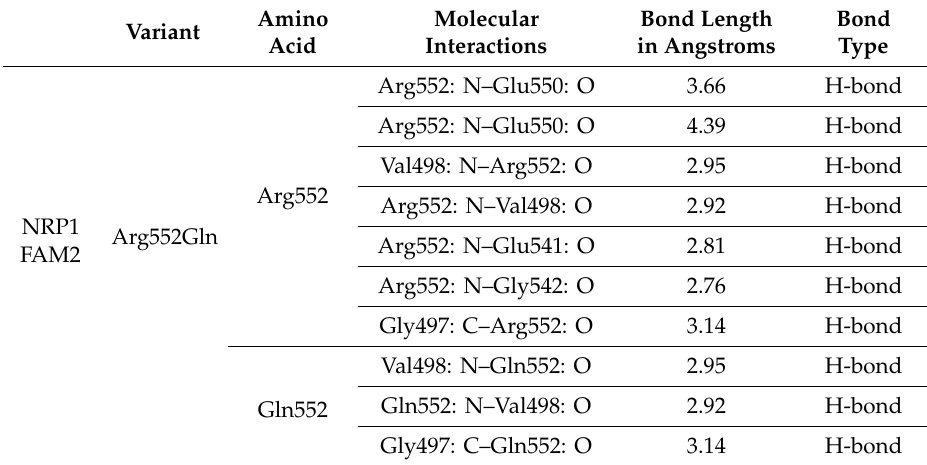
Figure 10. Molecular interactions of ( a ) Ile583 and ( b ) Thr583 (in yellow) of the modeled NRP2 protein with adjacent residues. Table 5. Details of molecular interactions with adjacent residues of wildtype Arg552 or variant Gln552 of the modeled NRP1 protein in family